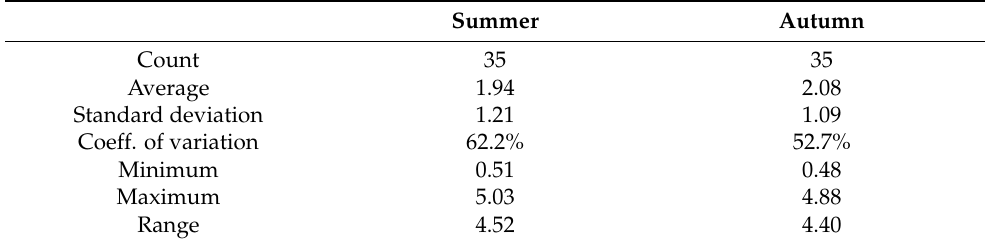
Figure 4. Average MC values of truckloads in increasing order for Autumn sampling period. The red line represents the average MC value (49.2%), black bars show the SD. Table 2. Analysis of the SD values of each trucks (relative to the 5 samples measured in each truck).